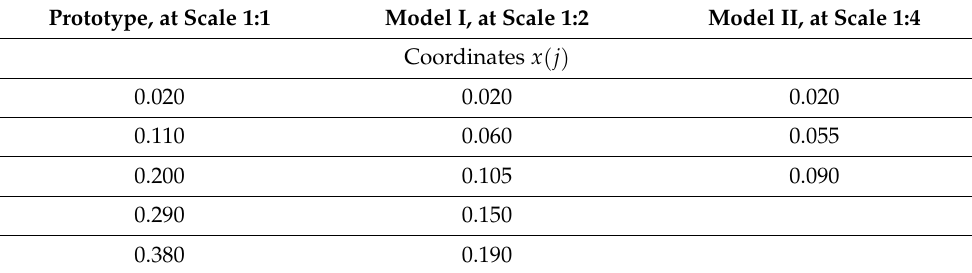
Table 2. Principal coordinates of the temperature measuring